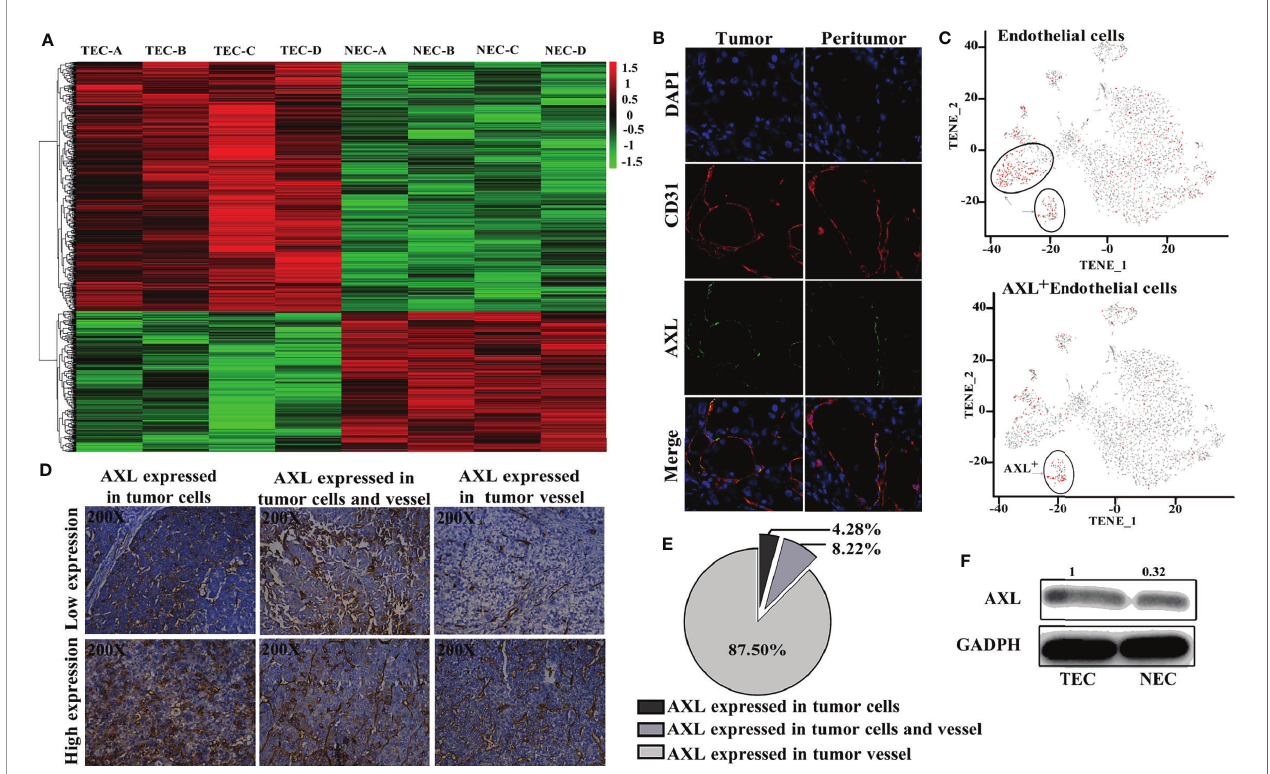
FIGURE 1 | AXL is mainly expressed in TECs. (A) Heat map of the differentially expressed genes in the Affymetrix U133 plus 2.0 array. (B) AXL and CD31 expression in the ECs of HCC samples. (C) AXL + ECs represent a subgroup of CD31 + ECs. (D) AXL expression in the vessels was present in 87.5% of the total samples. (E) AXL expression in the HCC cells was present in only 4.28% of the samples; AXL expression in both vessels and HCC cells was present in 8.22% of the samples. (F) AXL was expressed at higher levels in the TECs compared with the normal